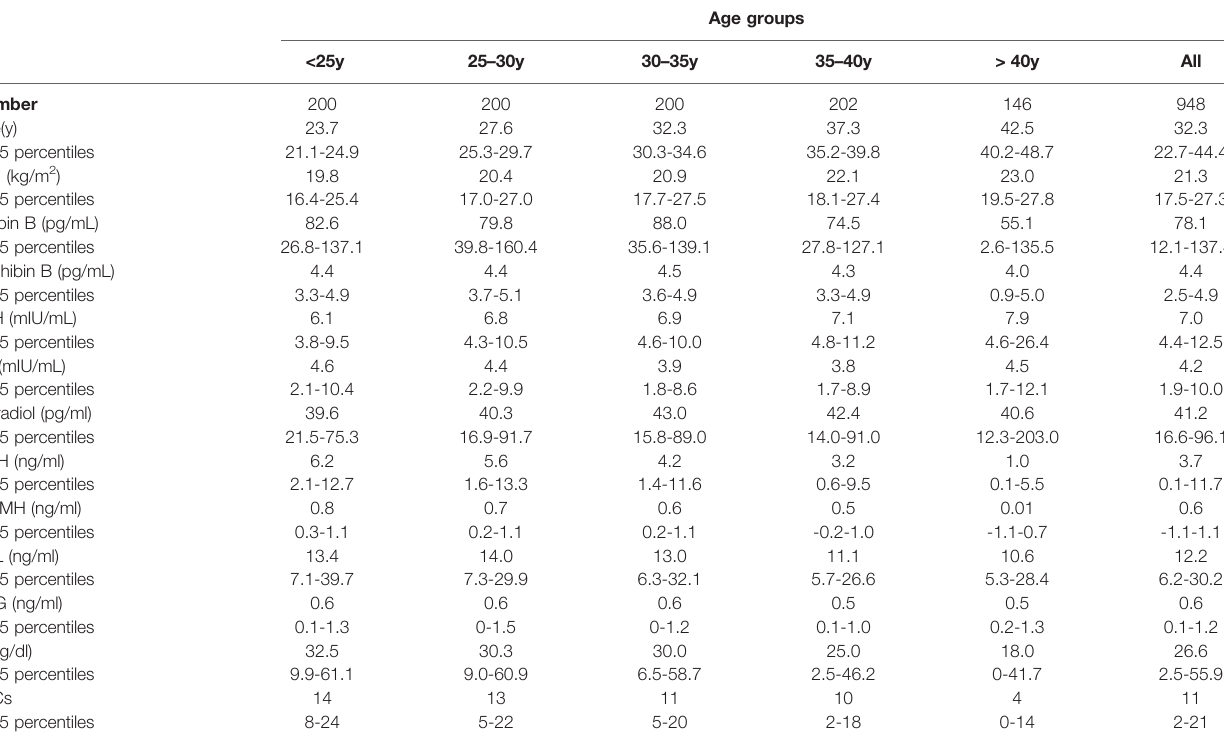
TABLE 1 | Median and 90% prediction interval (5 – 95 percentiles) of serum hormones and AFC in different age groups among the establishment population